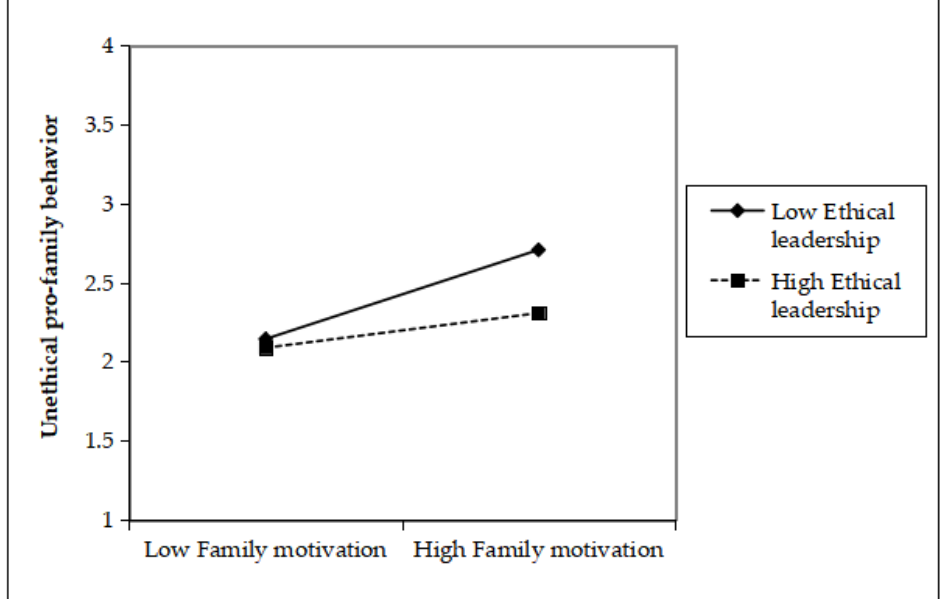
Figure 5. The Moderating Effect of Ethical Leadership. Hypothesis 6 proposed that ethical leadership dampens the indirect relationship